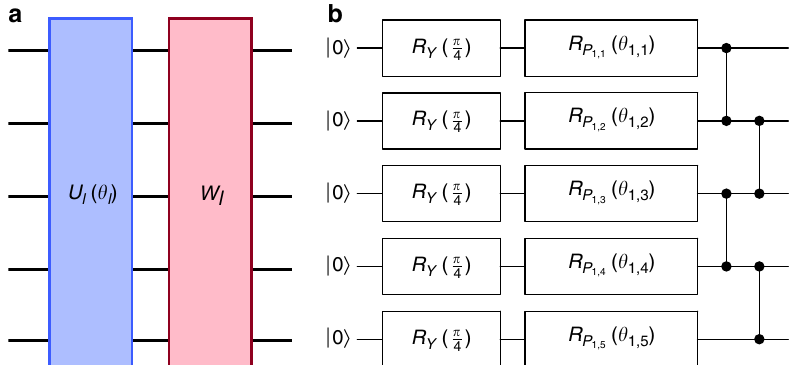
Fig. 2 Structure of quantum circuits. a The generic subunit of circuits we study in this work, with a parameterized component U l ( θ l ) and non-parameterized unit W l for each layer l . b Example schematic of the 1D random circuits used in our numerical experiments. The circuit begins with R Y π qubits followed by a speci fi ed number of layers of randomly chosen Pauli rotations applied to each qubit and then a 1D ladder of controlled Z gates. The (cid:5) (cid:6) initial R Y π gates are not repeated in each layer. The indices i and j in θ i , j index the layer and qubit, respectively. For each layer and qub it P i , j ∈ { X , Y , Z } 4 and θ i , j ∈ [0,2 π ) are sampled